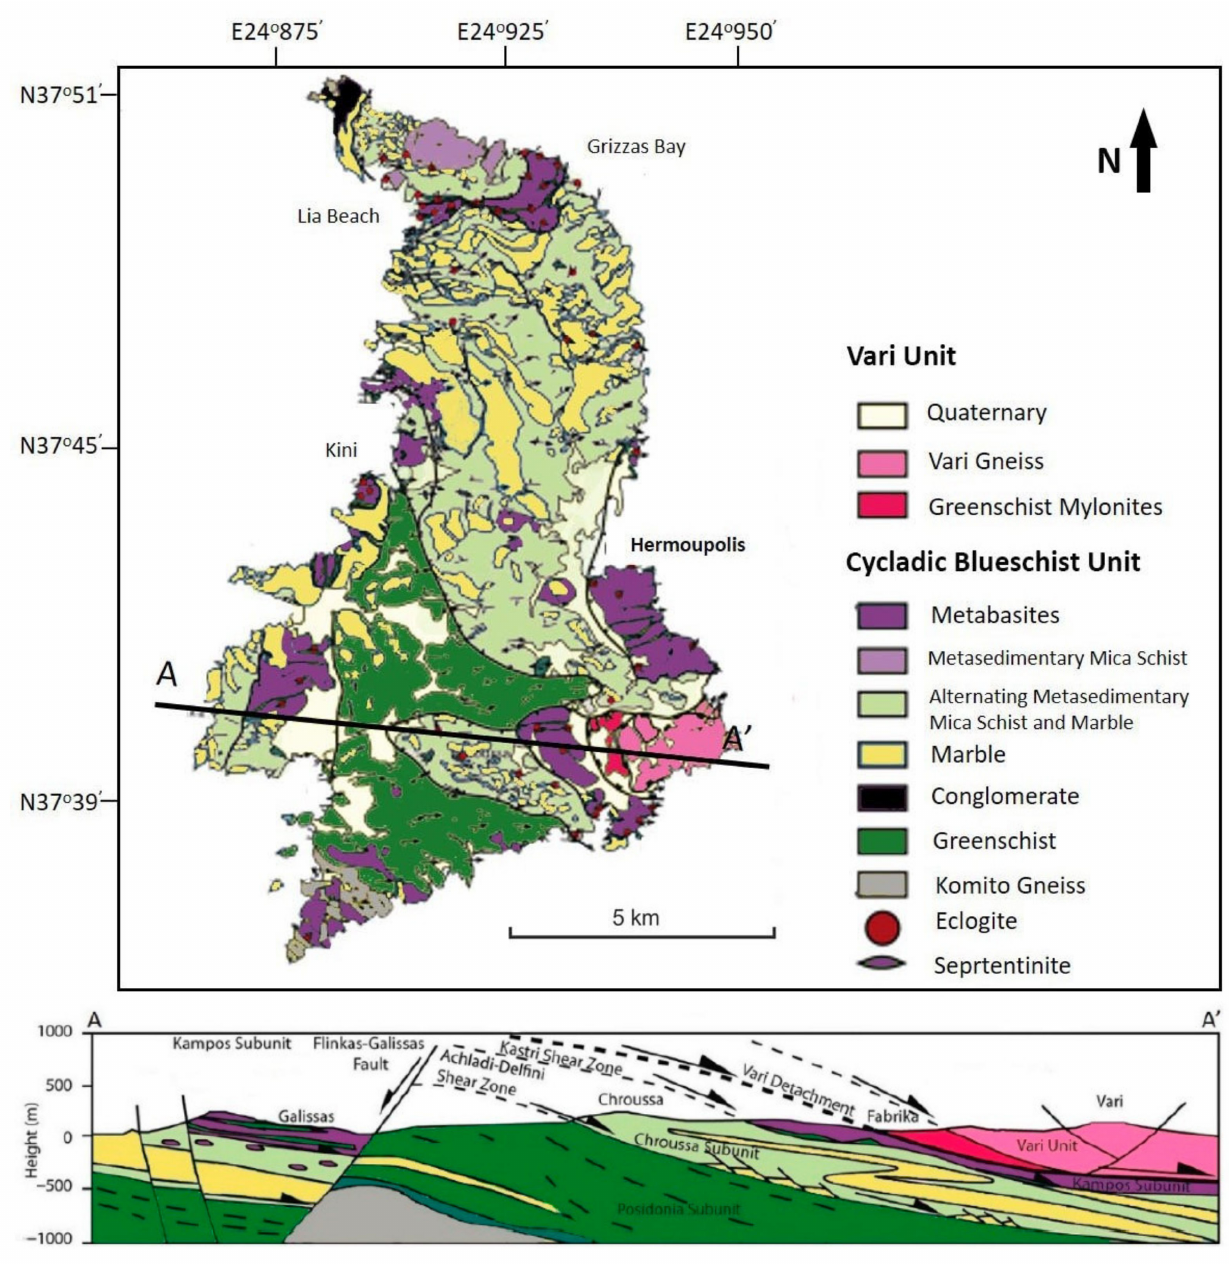
Figure 4. Geological map and cross-section of Syros island, simplified after [16,17,20,22] and our own